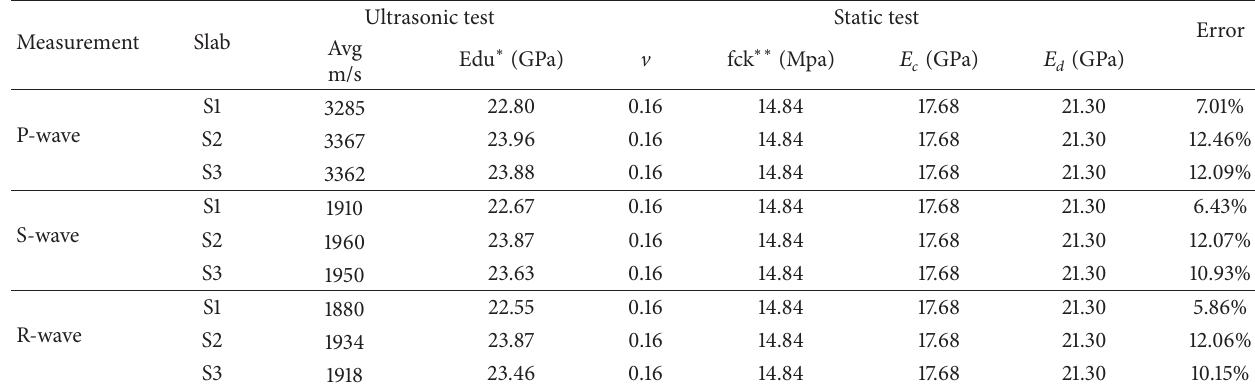
Table 6: Comparison of dynamic moduli from ultrasonic and static tests.